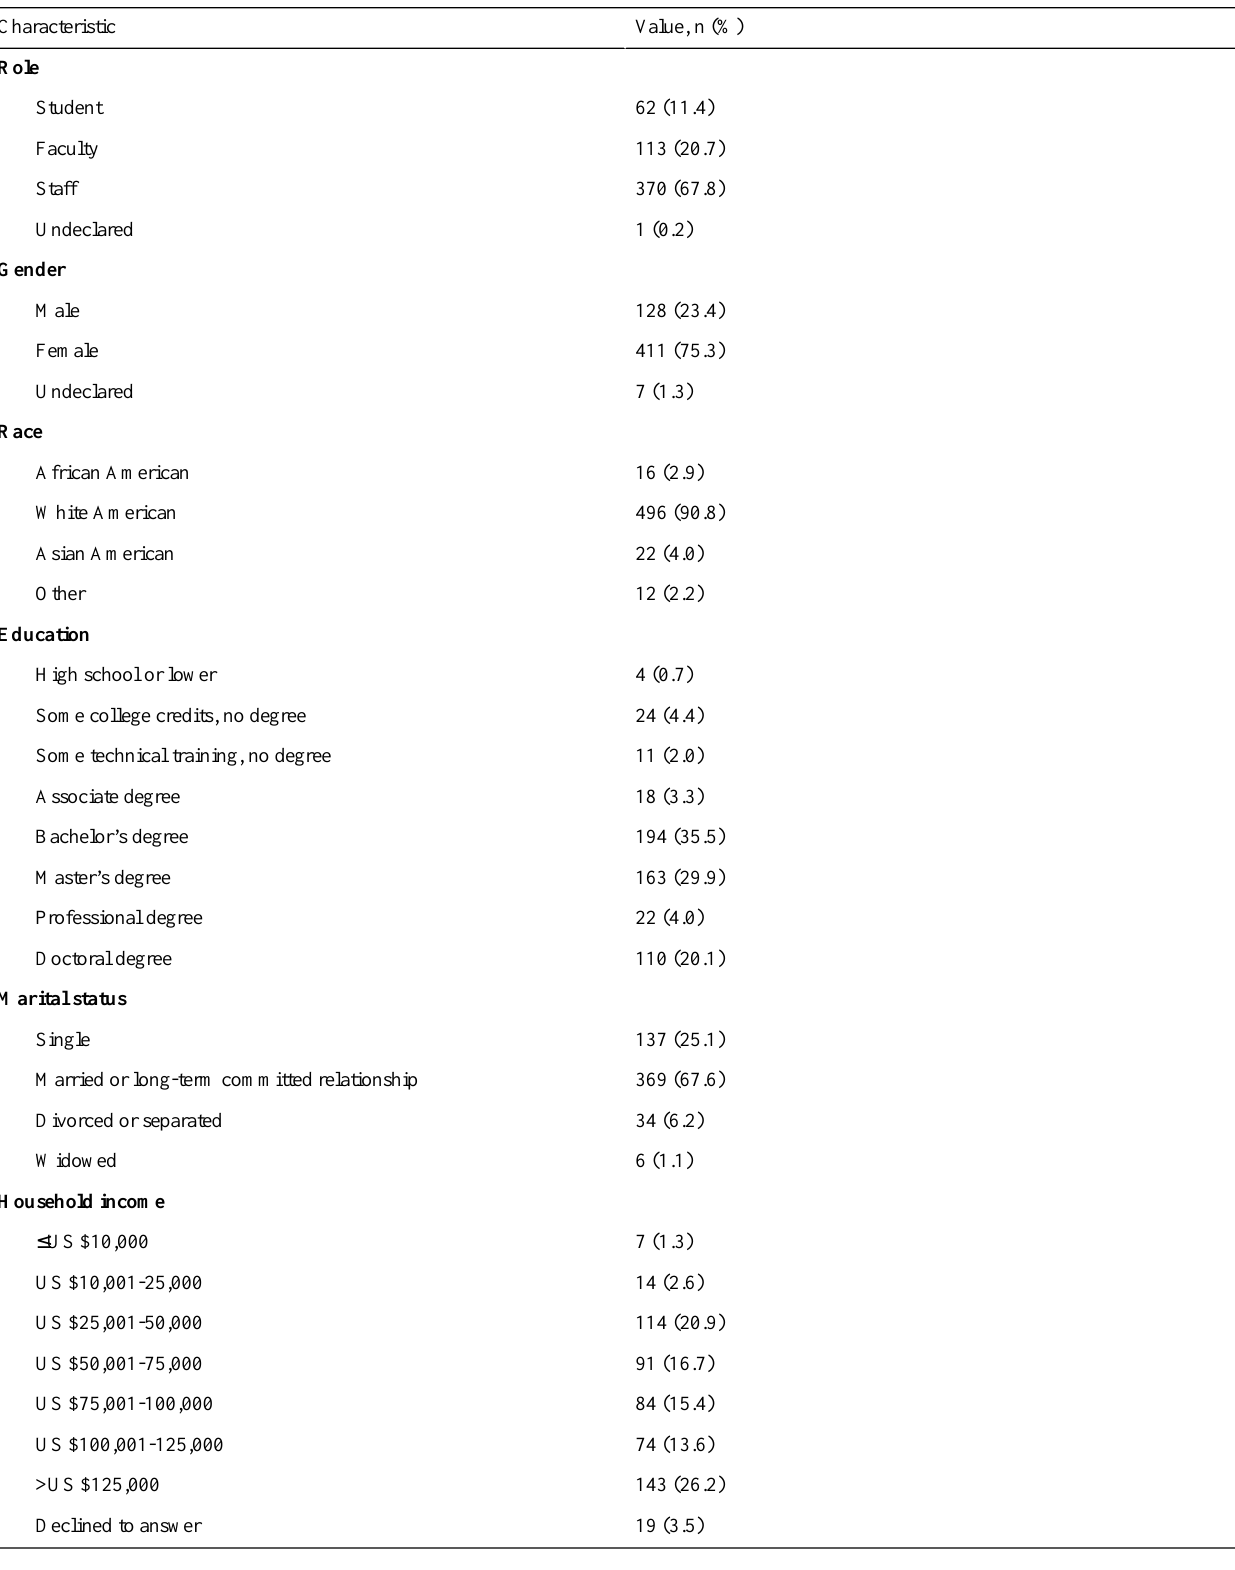
Table 3. Demographic information of the 546 study participants who provided responses to all the statements in the new well-being